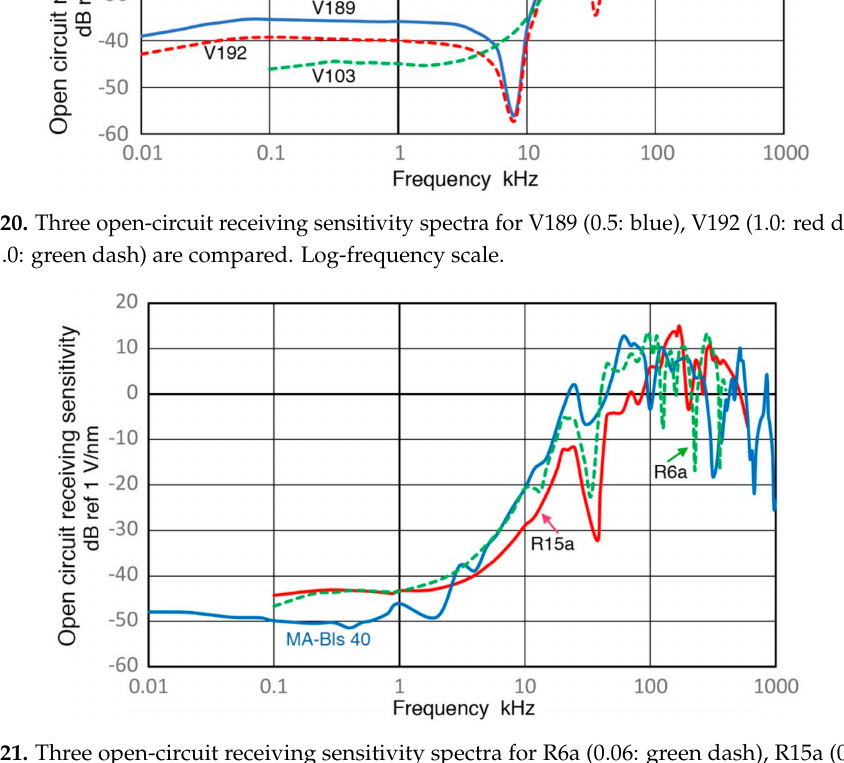
Figure 21. Three open-circuit receiving sensitivity spectra for R6a (0.06: green dash), R15a (0.15: red) and MA-Bls 40 (blue) are compared. Log-frequency scale.